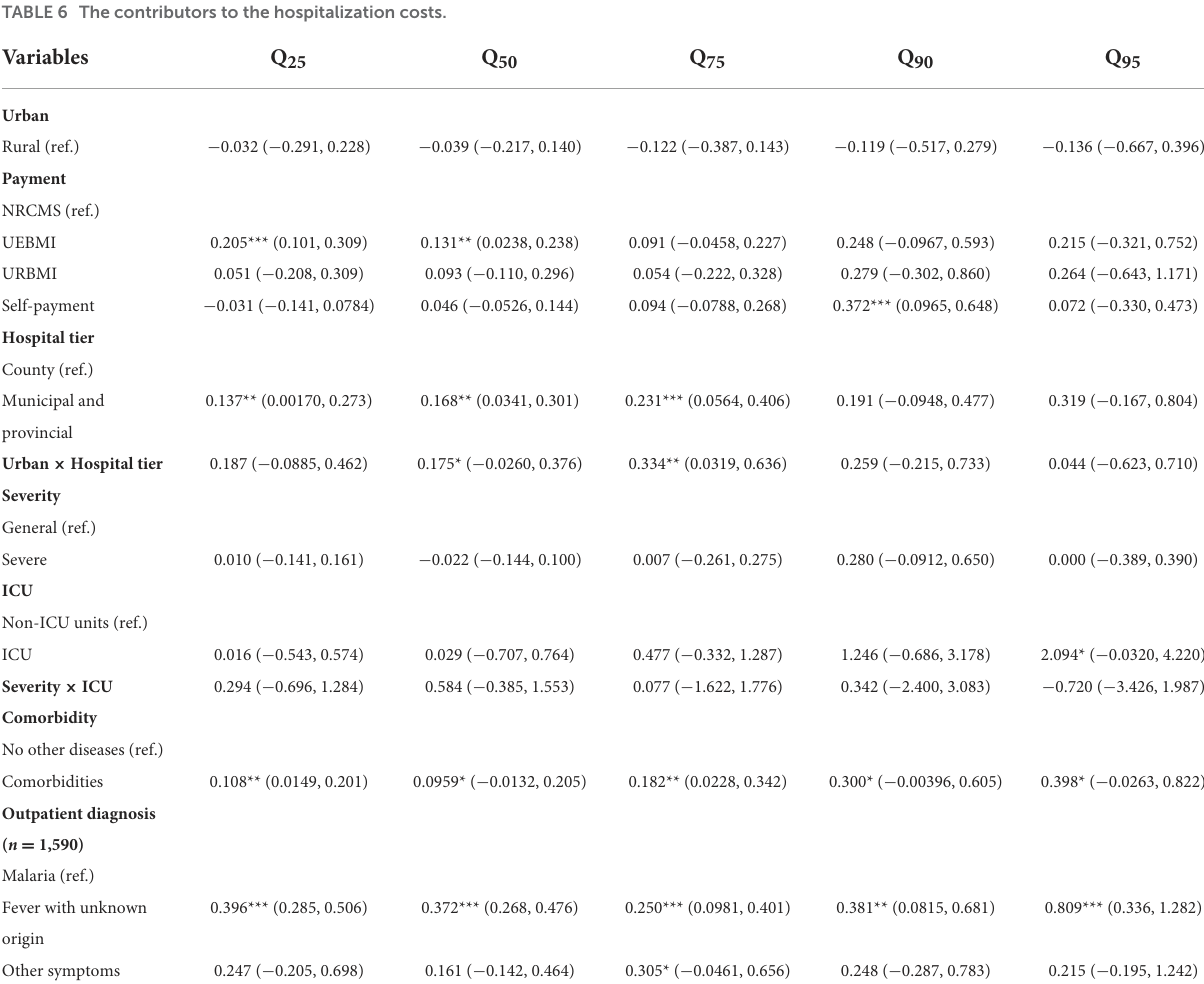
TABLE 6 The contributors to the hospitalization